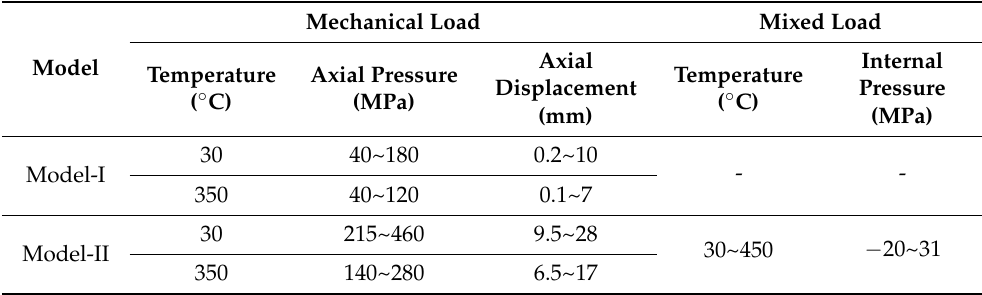
Table 2. Load type and peak load range of each